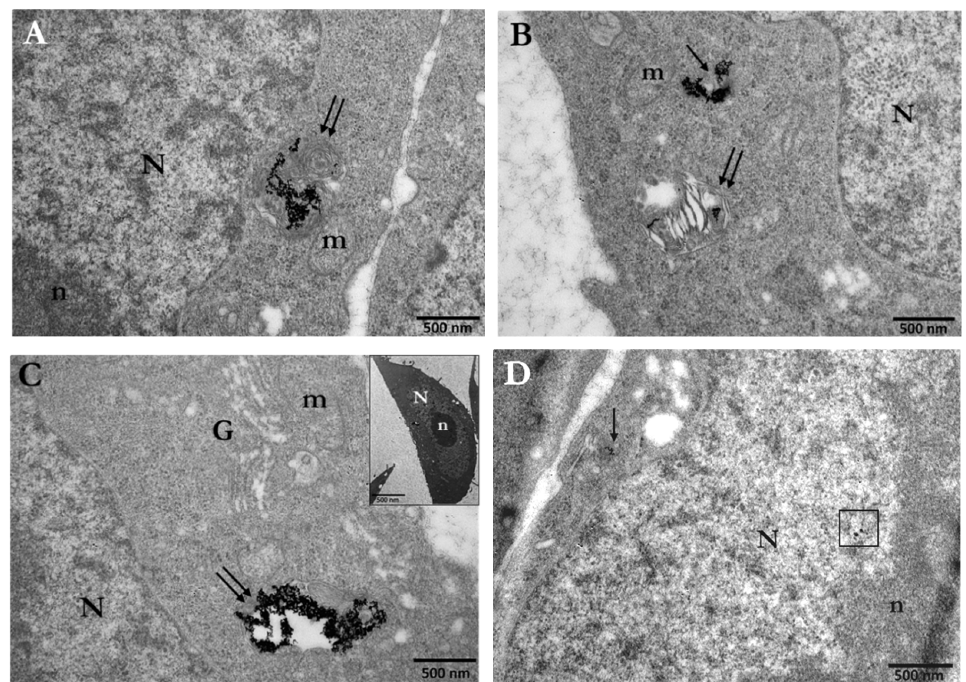
Figure 5. Electron micrographs of PC3 cells incubated for 24 h with 5 nm PEG-AuNPs (30 μ g/mL). ( A ) Image depicts the accumulation of PEG-AuNPs inside an autophagosome (double arrows), which is located right next to the nuclear envelope. ( B ) Image depicts the localization of PEG-AuNPs in the cytoplasm (single arrows) and inside an autophagosome (double arrows) that seems to have also taken up a damaged mitochondrion. ( C ) Numerous PEG-AuNPs are located inside an autoph- agosome (double arrows). ( D ) Image depicts the localization of a few 5 nm PEG-AuNPs inside the nucleus (black box). N: nucleus, n: nucleolus, m: mitochondrion, G: Golgi apparatus. Scale bars = 500 nm.